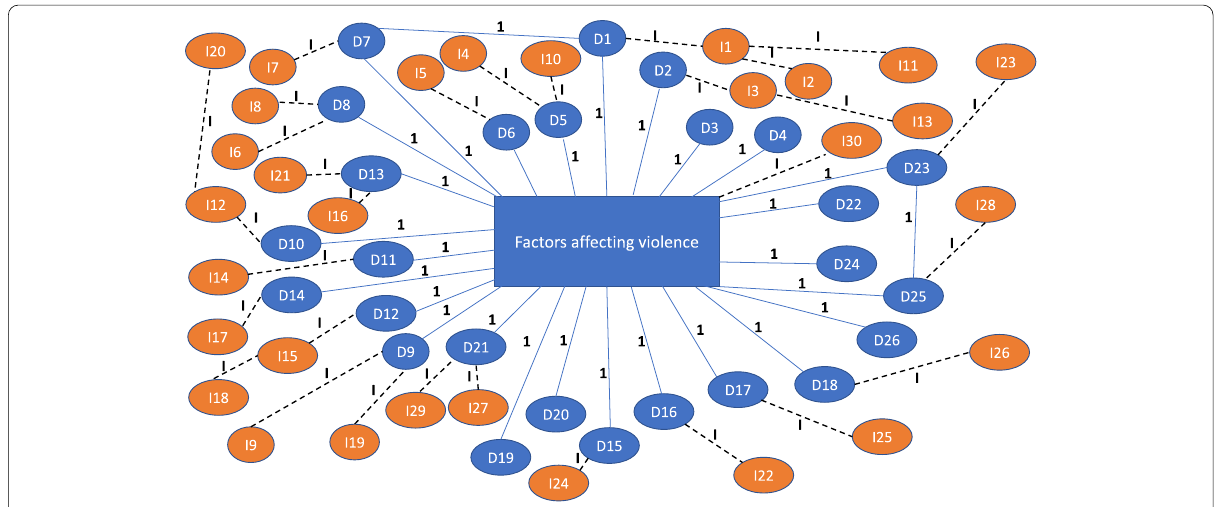
Fig. 7 Neutrosophic Cognitive Map for factors affecting